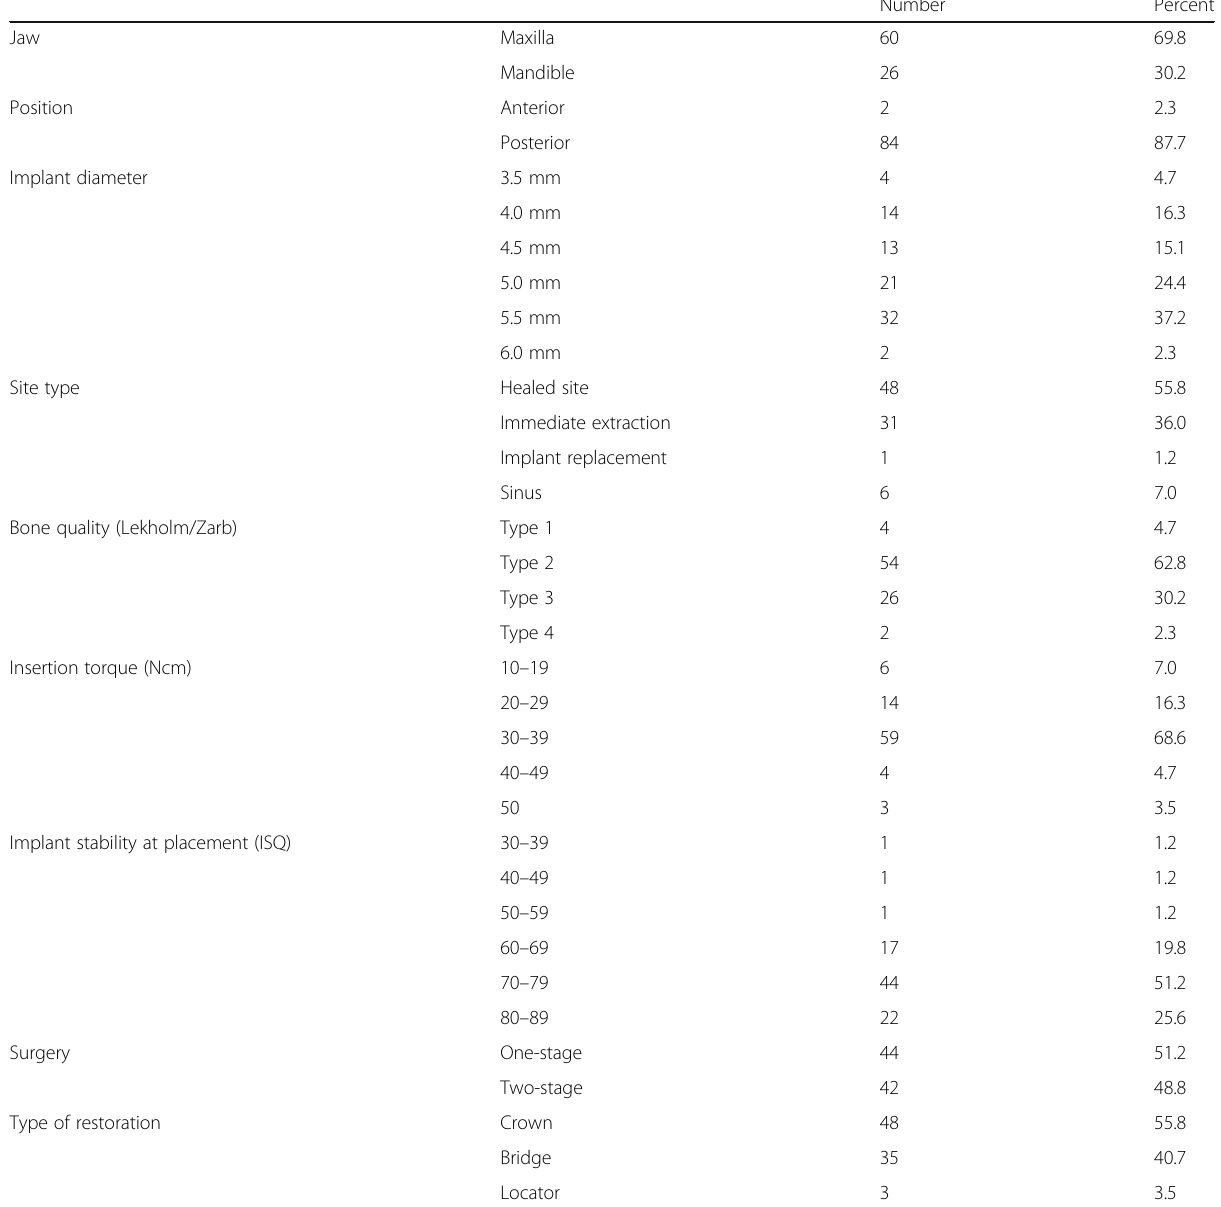
Table 2 Implant and site-related specifications